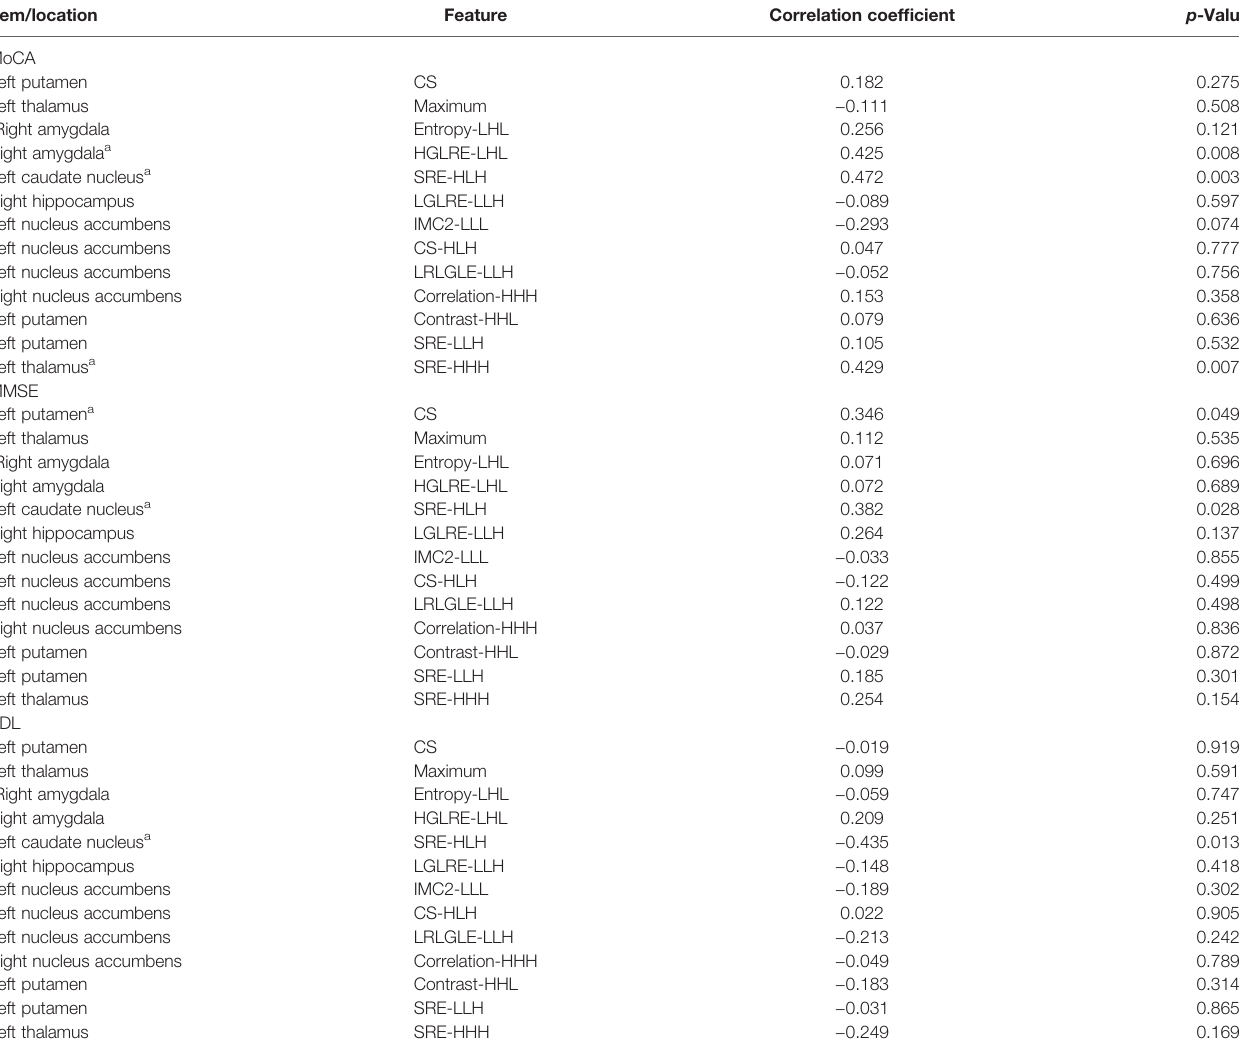
TABLE 3 | Correlation tests between radiomics features of optimal subset and MoCA, MMSE, and ADL cores.